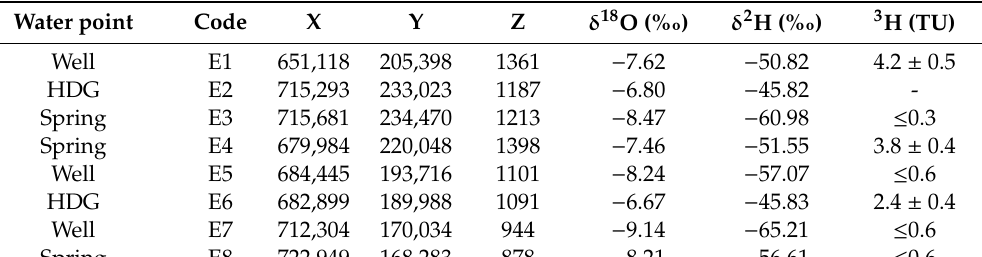
Table 5. Groundwater stable isotope data.